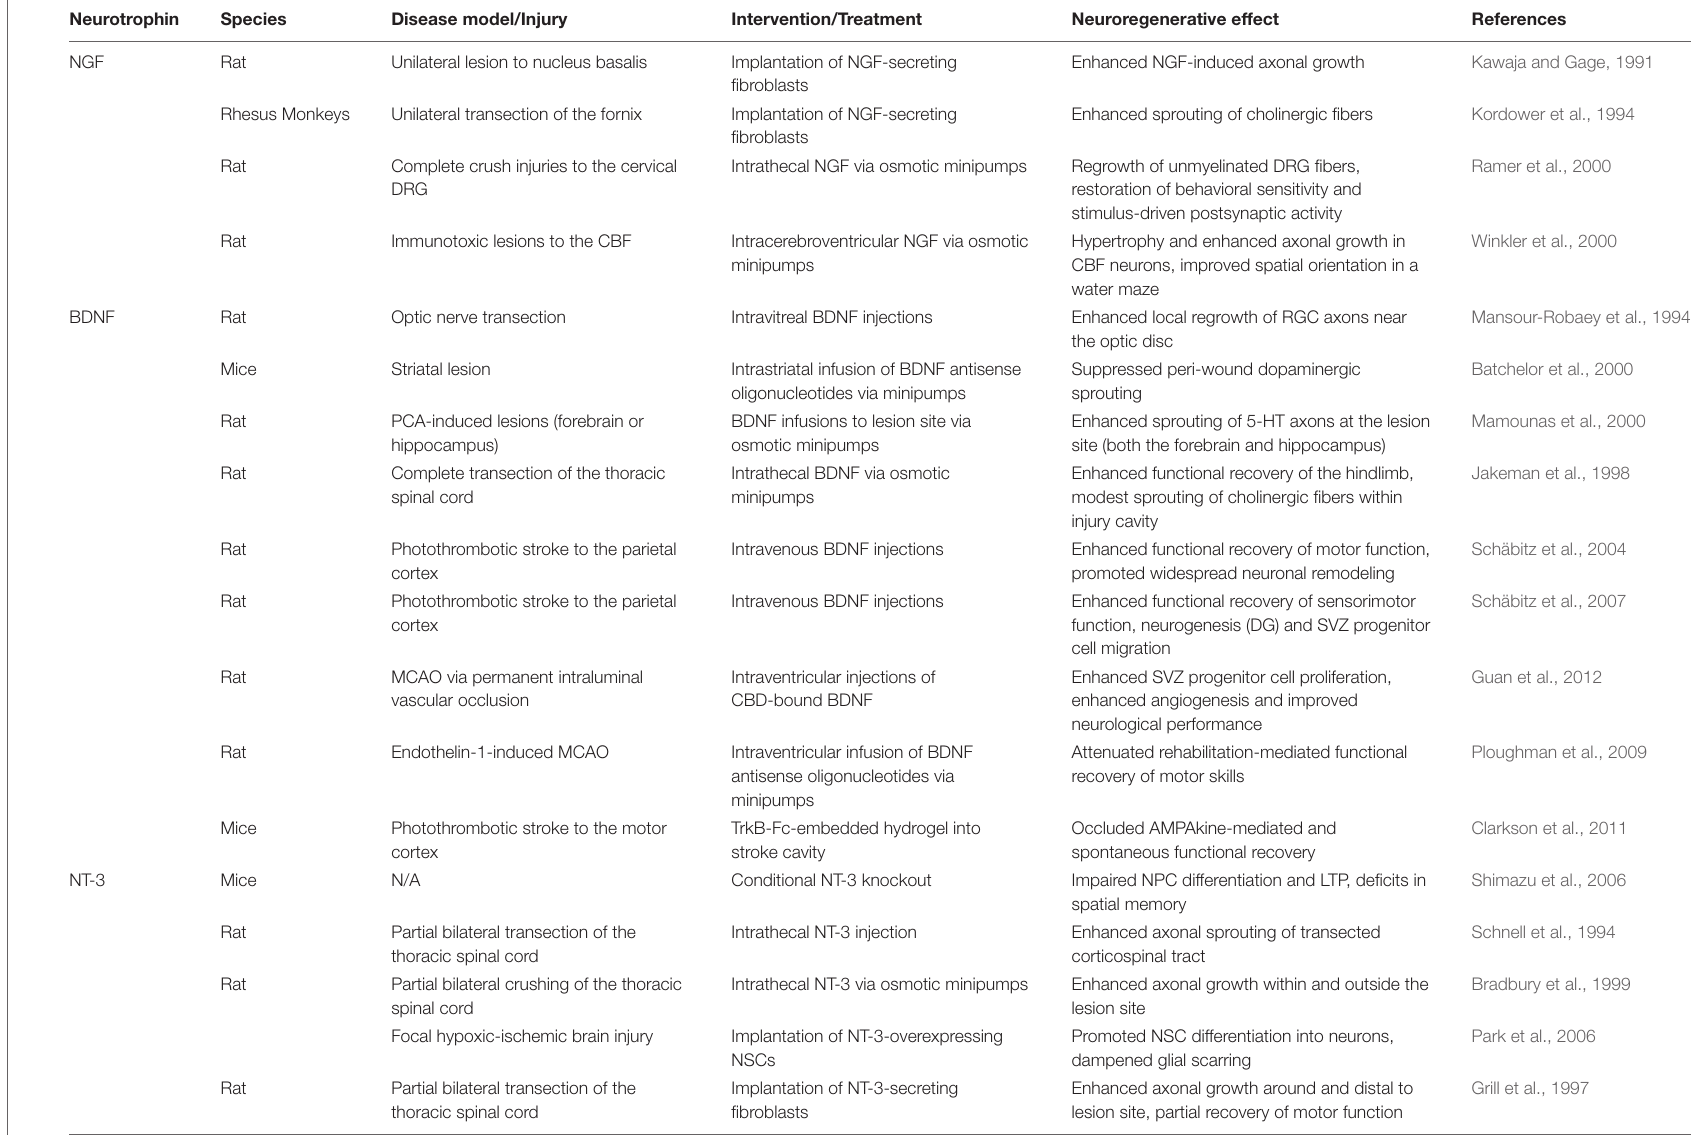
DRG, dorsal root ganglion; CBF, cholinergic basal forebrain; RGC, retinal ganglion cells; PCA, p-chloroamphetamine; DG, dentate gyrus; SVZ, subventricular zone; MCAO, middle cerebral artery occlusion; CBD, collagen binding domain; TrkB-Fc, tropomyosin receptor kinase B-Fc; NPC, neural progenitor cell; LTP, long term potentiation; NSC, neural stem